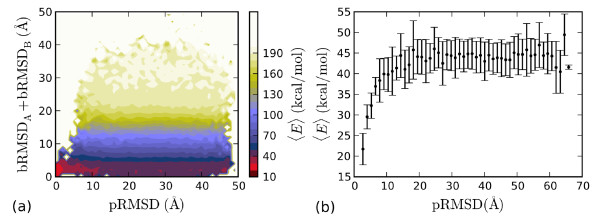
The heterodimeric AB zipper. (a) Mean energy as a function of pRMSD over both chains and the sum of individual bRMSDs. The direction of the energy gradients implies that a system with two folded monomers is energetically favorable compared to unfolded monomers. The proper dimeric form is the area closest to the origin, and has a lower energy. (b) Mean energy of all states in which both chains have bRMSD < 5 Å, shown as a function of the dimer RMSD measure pRMSD.